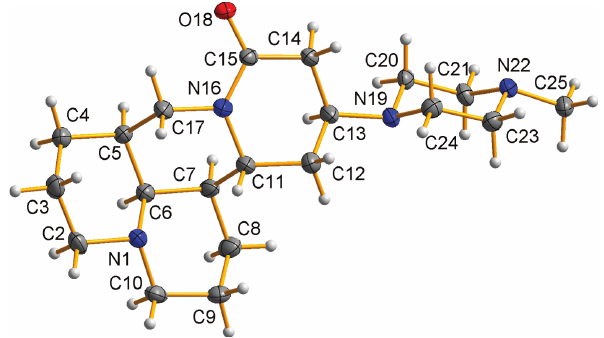
Table 1: Data collection and handling.